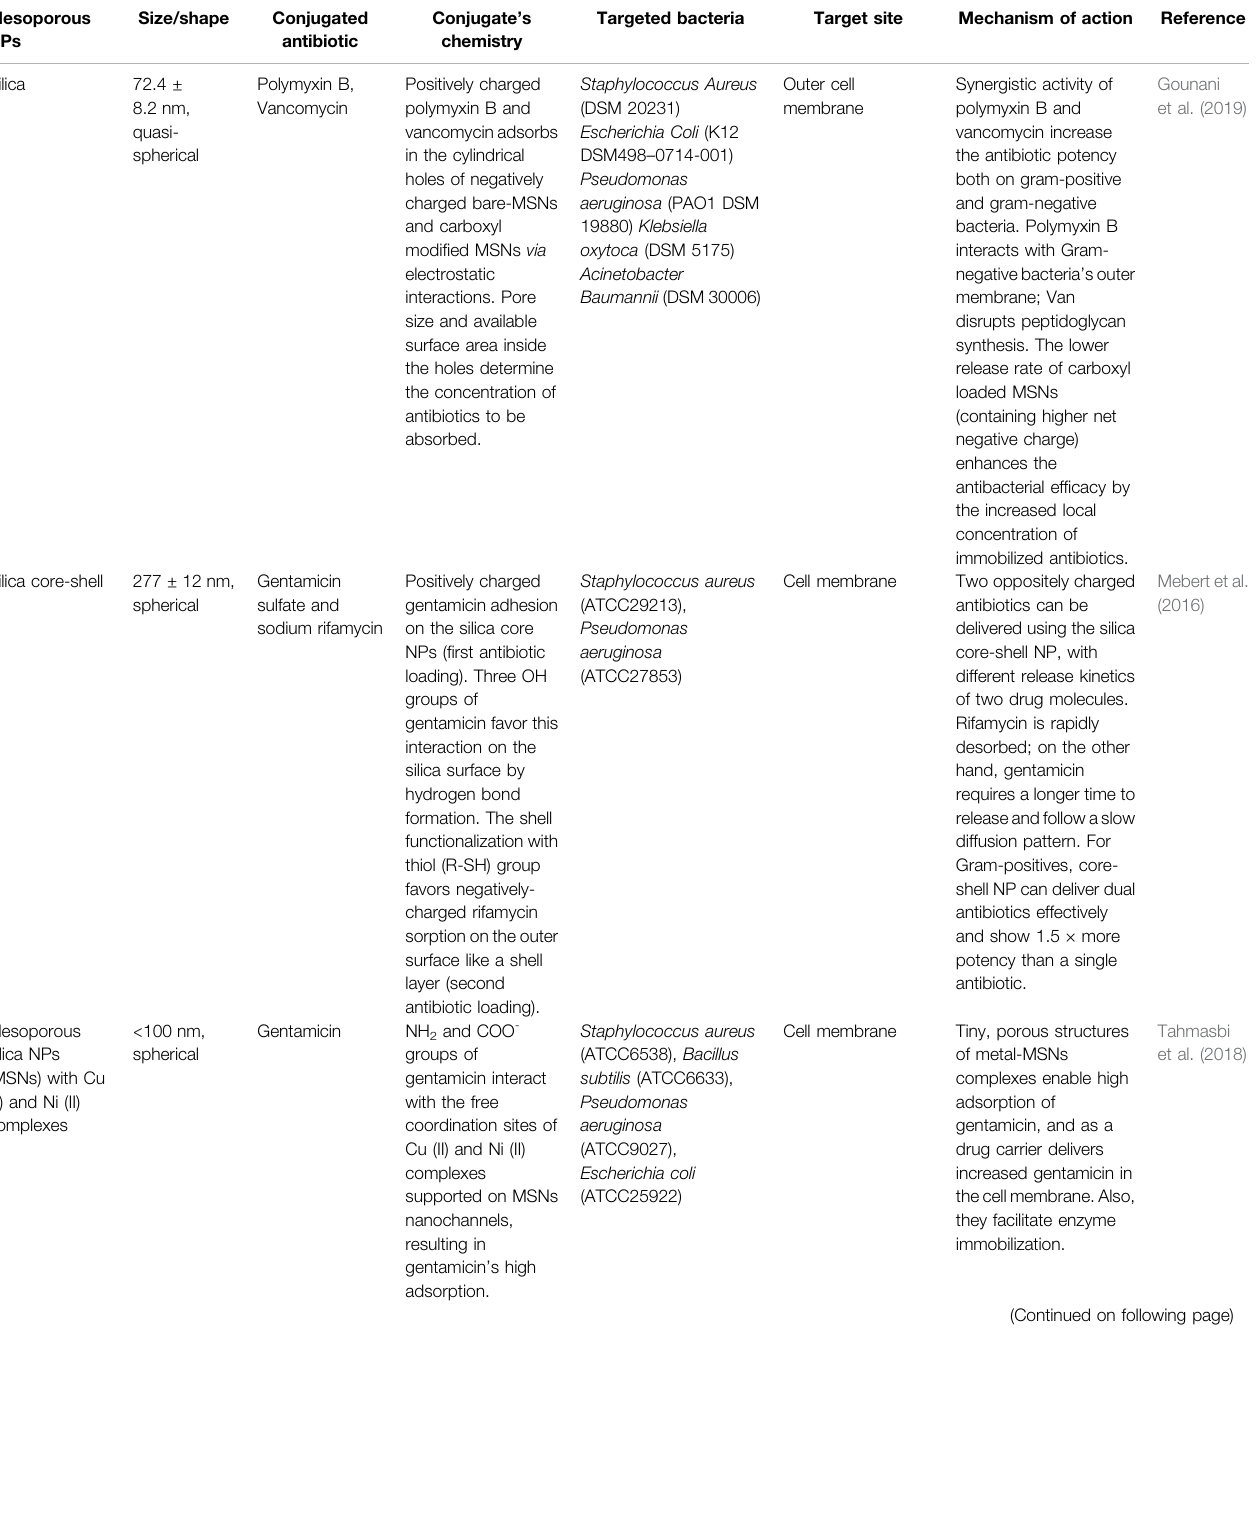
TABLE 7 | Different types of mesoporous nAbts and their associated